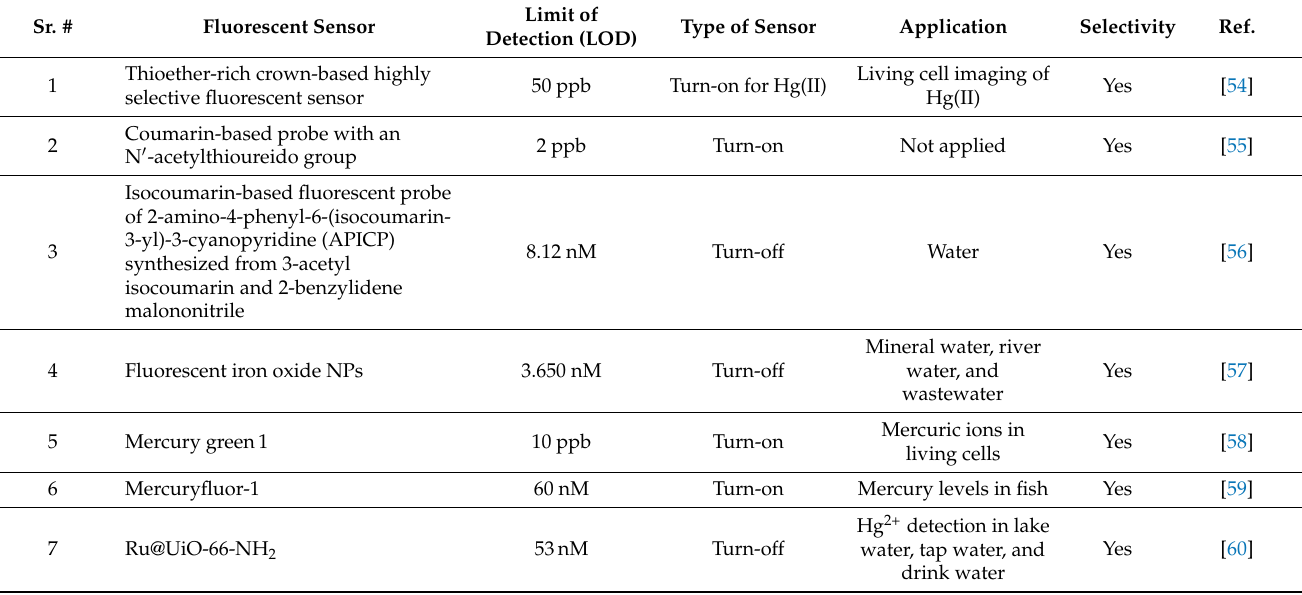
Table 2. Comparisons of various fluorescent chemo-sensors for Hg 2+ ions sensing. Sr. #